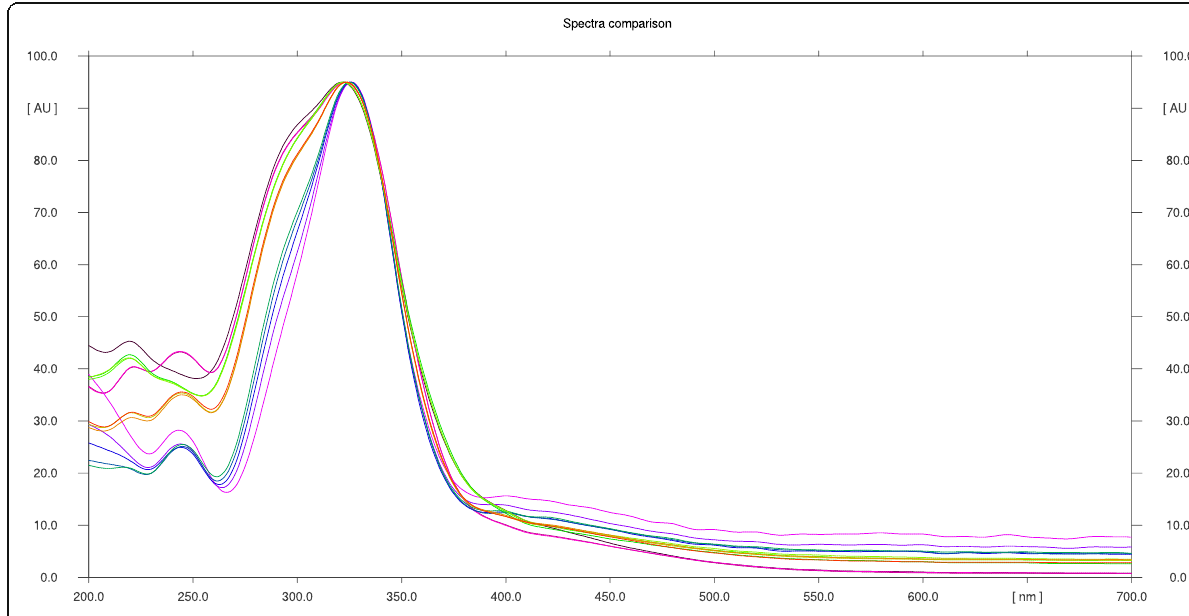
Fig. 4 Overlain spectrum of test samples with CA standard, scanned at 330